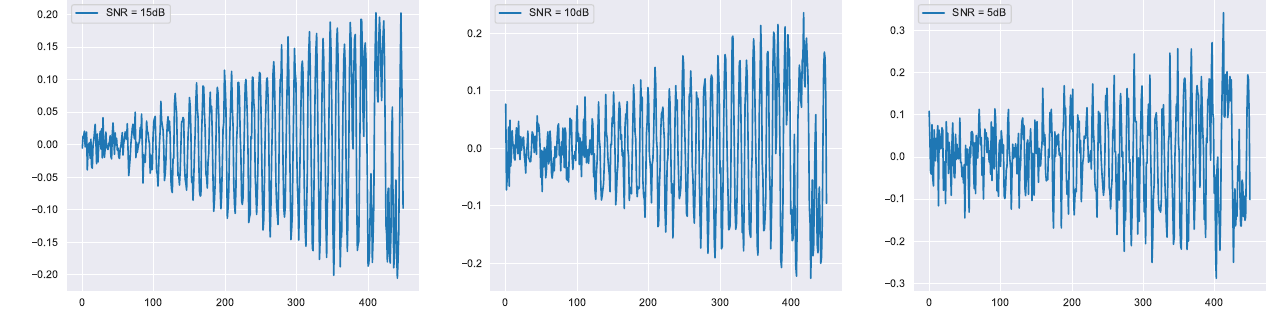
Figure 10. XBee’s RF signal with different SNR